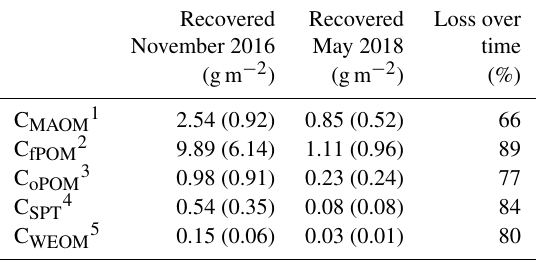
Table 3. Mean contents of labeled litter-derived OM in different soil fractions of all depth increments used for density fractiona- tion (0–50cm, 100–140cm), 22 months (November 2016) and 40 months (May 2018) after labeled litter application ( n = 3; standard deviation is given in brackets). The percentage loss over 18 months was calculated based on differences in C contents in OM fractions at both samplings. Overall, 36%–40% of the initially applied litter was lost by respiration during 22 months of field exposure (Wordell- Dietrich,